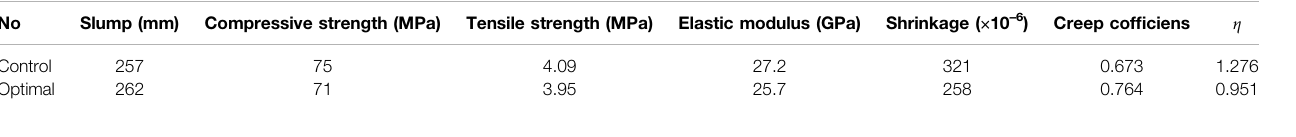
TABLE 9 | Performance comparison between control and